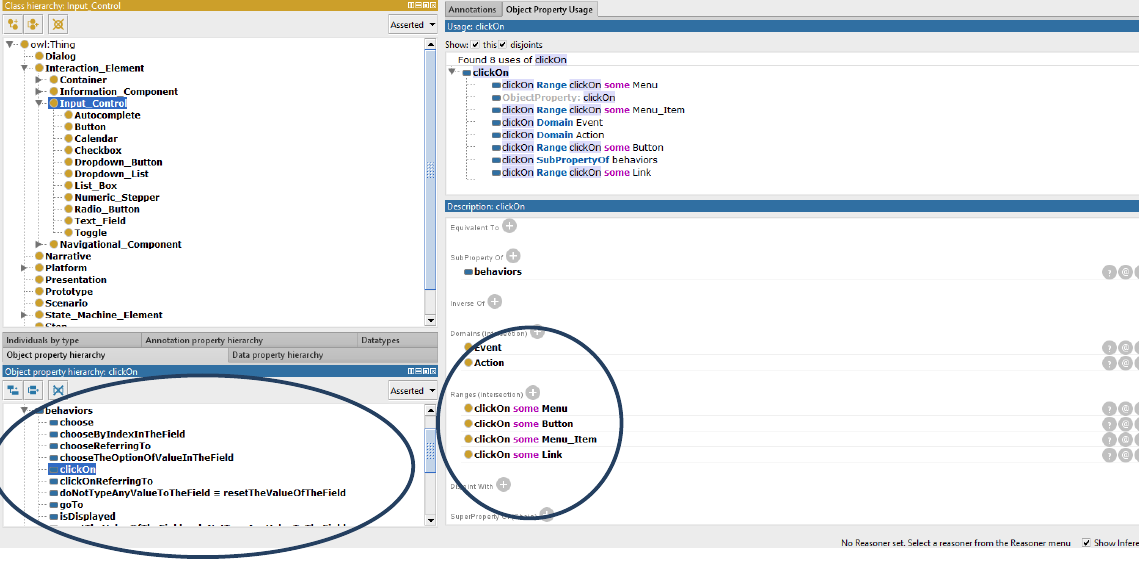
Figure 7. Ontology structure highlighting the definition of